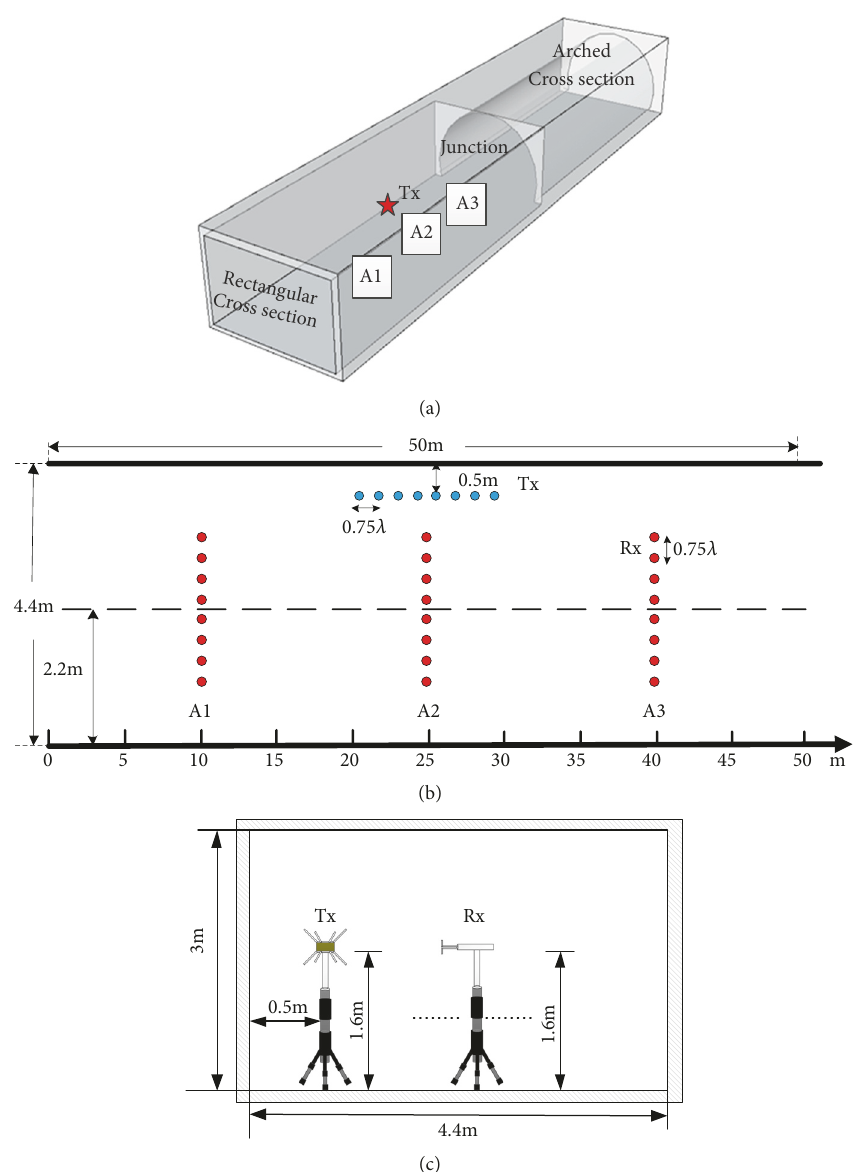
Figure 11: Nantong short channel. (a) 3D tunnel geometric model. (b) Tunnel top view. (c) Tunnel sectional